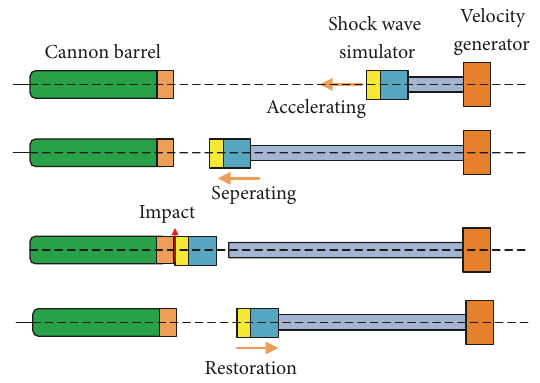
Figure 3: Shock and restoration